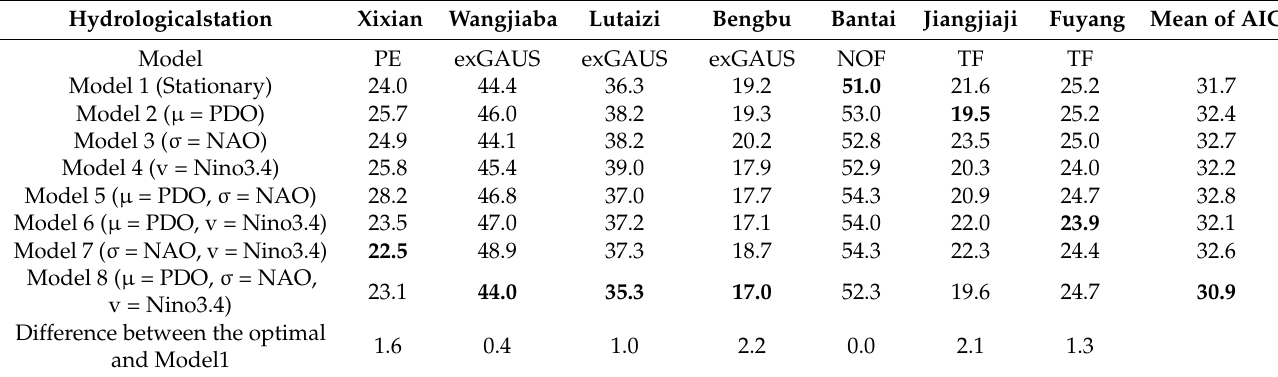
Table 3. GAMLS results and AIC values.